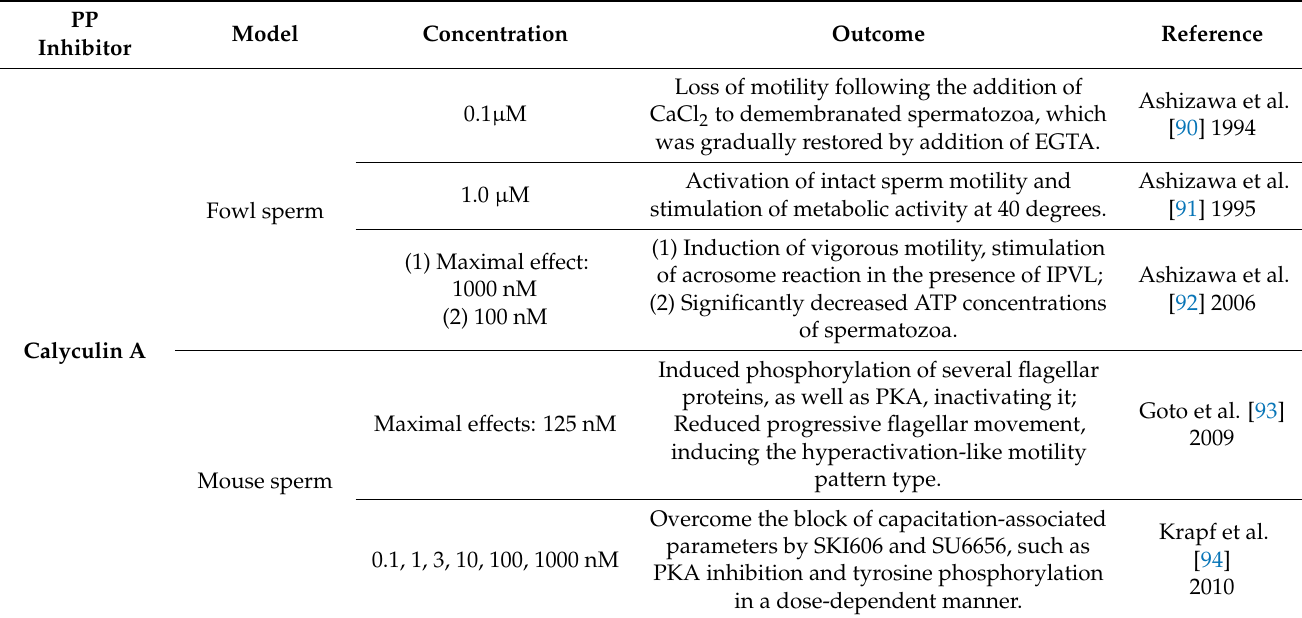
Table 1. Reports on the inhibition of PP1, PP2A and PP2B by the PP inhibitors CA, OA, DEL, CsA and E in sperm. For each report, the PP inhibitor, spermatozoa model, concentration required for inhibition and outcome achieved is